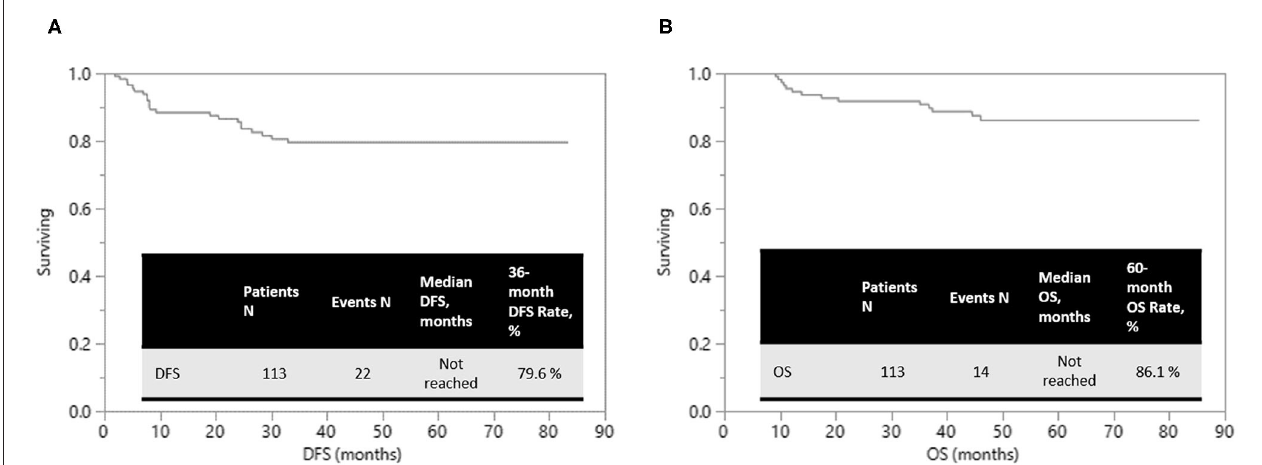
FIGURE 2 | The Kaplan–Meier survival curves. (A) Overall survival. (B) Disease-free survival.